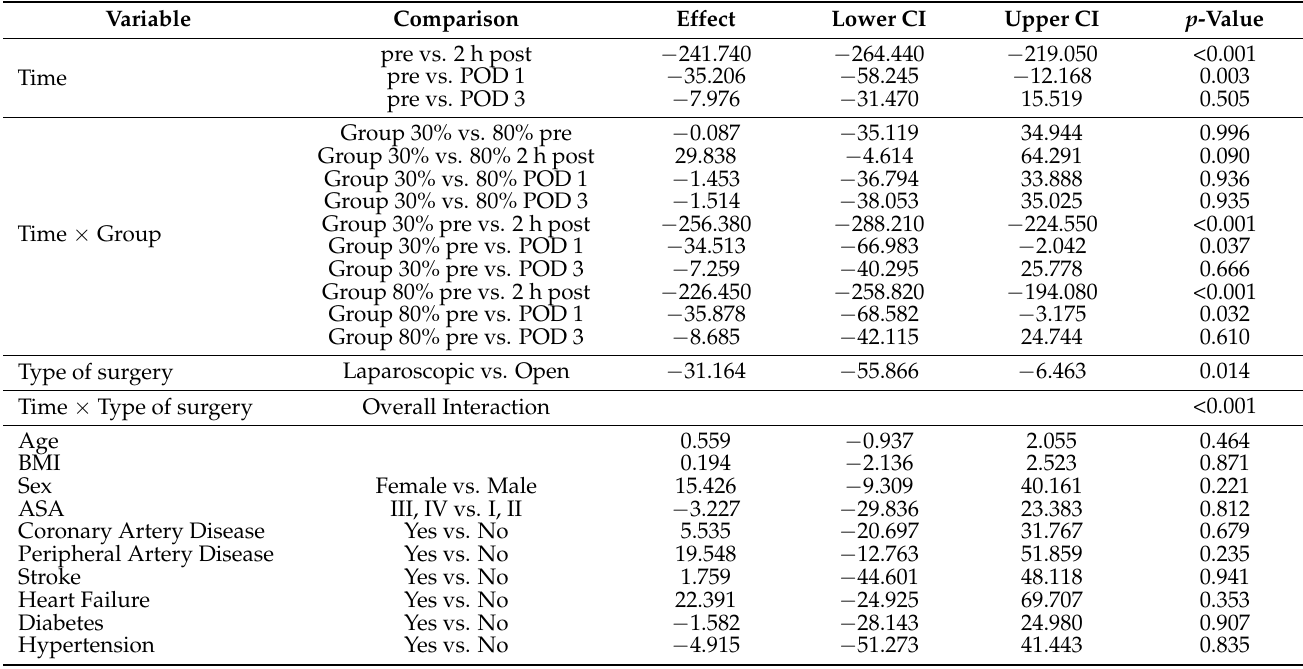
Figure 2. Plot showing the perioperative trend of Copeptin concentrations between patients who received 0.8 FiO 2 (red) and patients who received 0.3 FiO 2 (black). Dots represent mean values, vertical lines represent standard deviations of each group. The blank dots give the values of the observed individuals separately for the two groups. Table 3. Univariable regression model